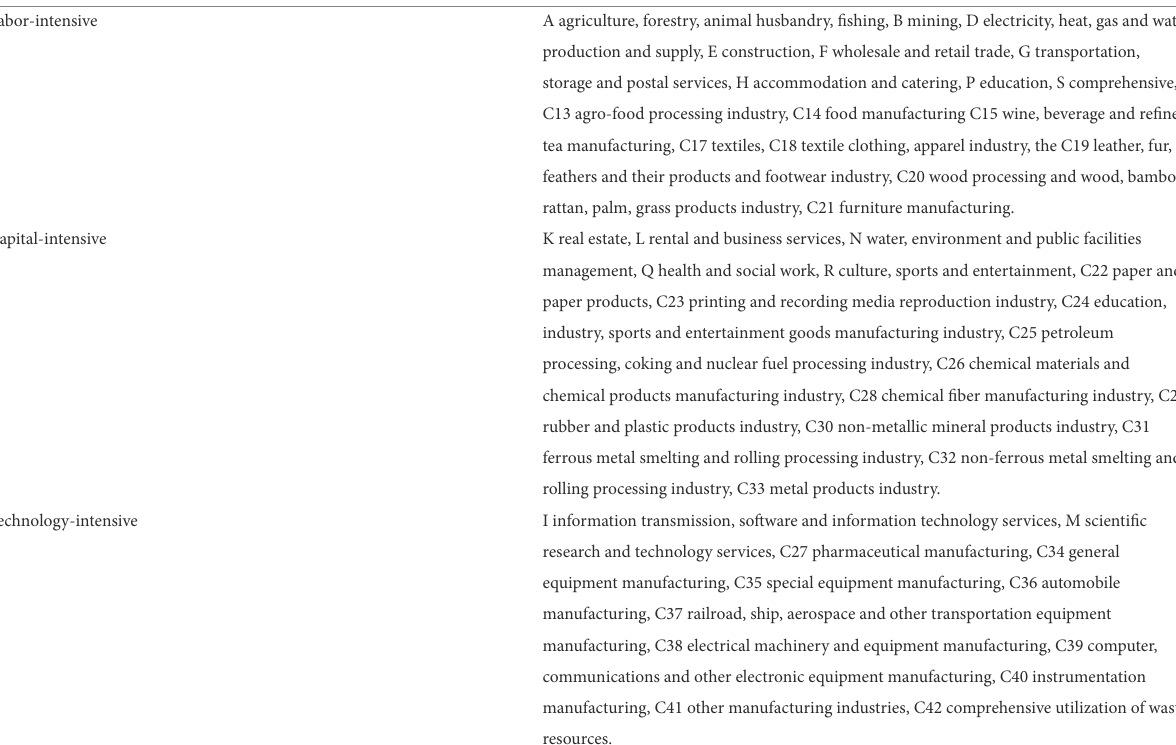
TABLE 9 Industry